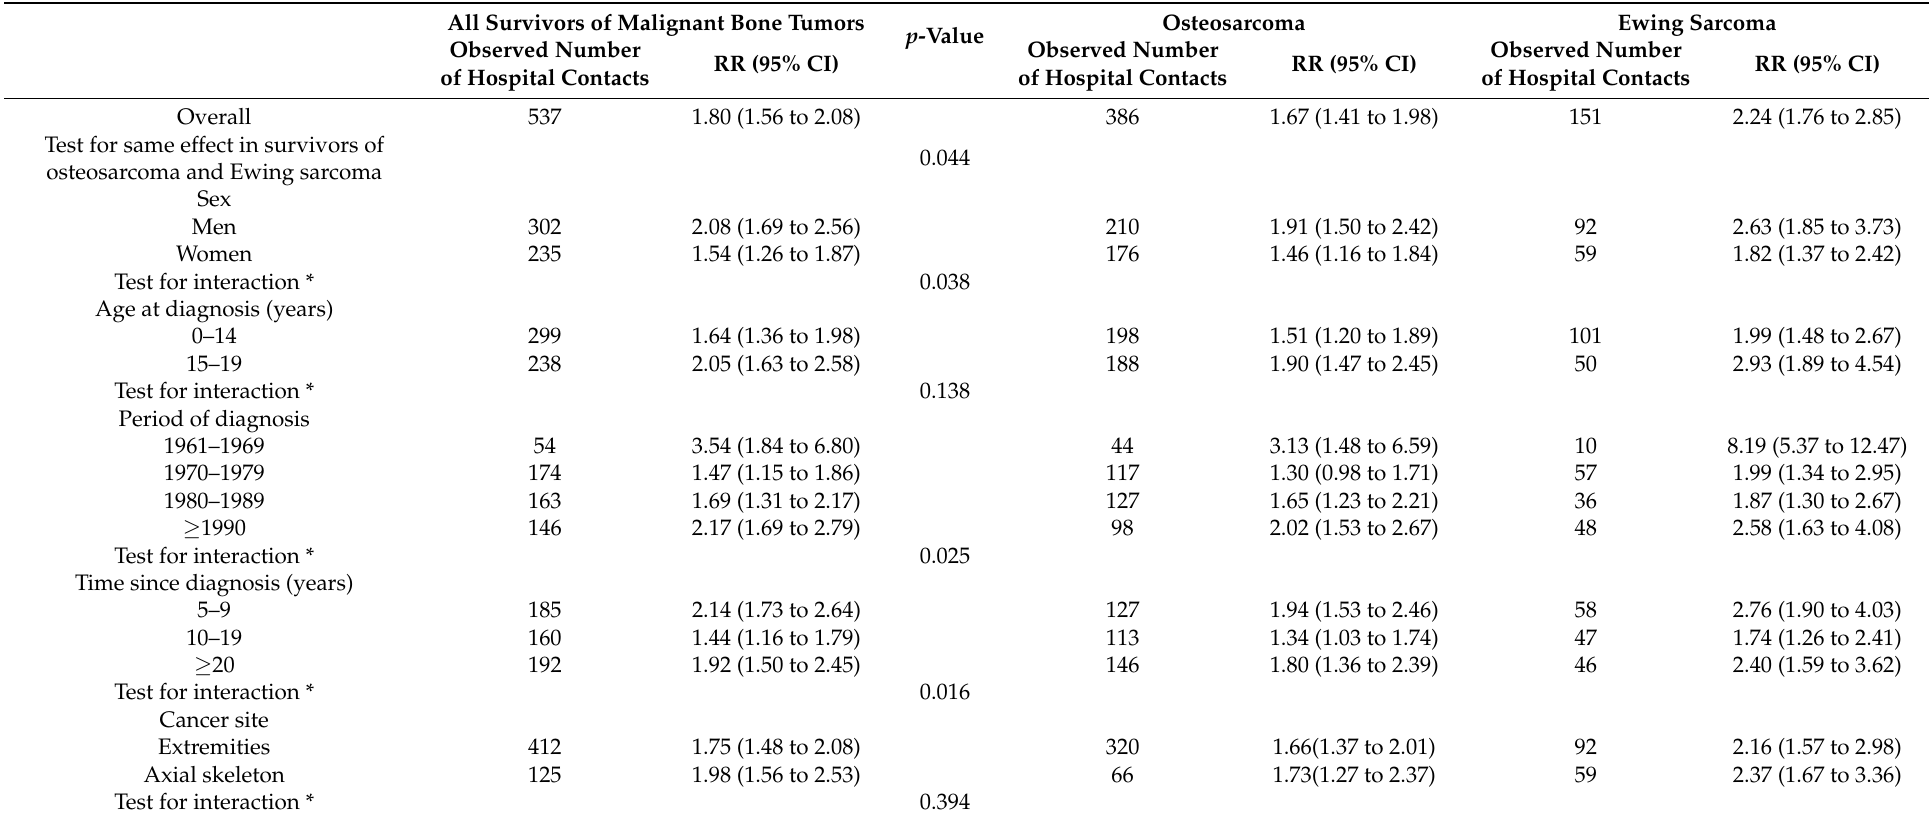
Table 2. Rate ratios of hospital contacts (RRs) and 95% confidence intervals (CIs) for all survivors of malignant bone tumors and for the sub-cohorts of survivors of osteosarcoma and Ewing sarcoma compared with the matched comparison cohort, stratified by sex, age at diagnosis, year of diagnosis, years since diagnosis, and cancer